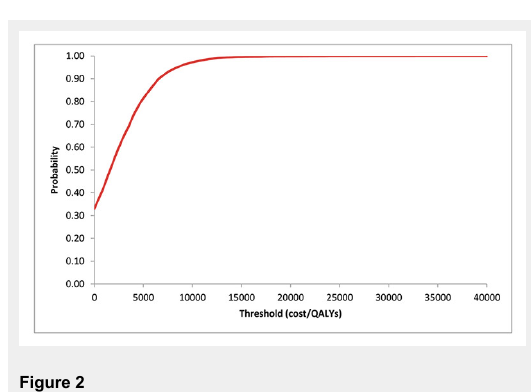
Cost-effectiveness acceptability curve for ticagrelor. Incremental costs and effects are calculated as ticagrelor minus generic